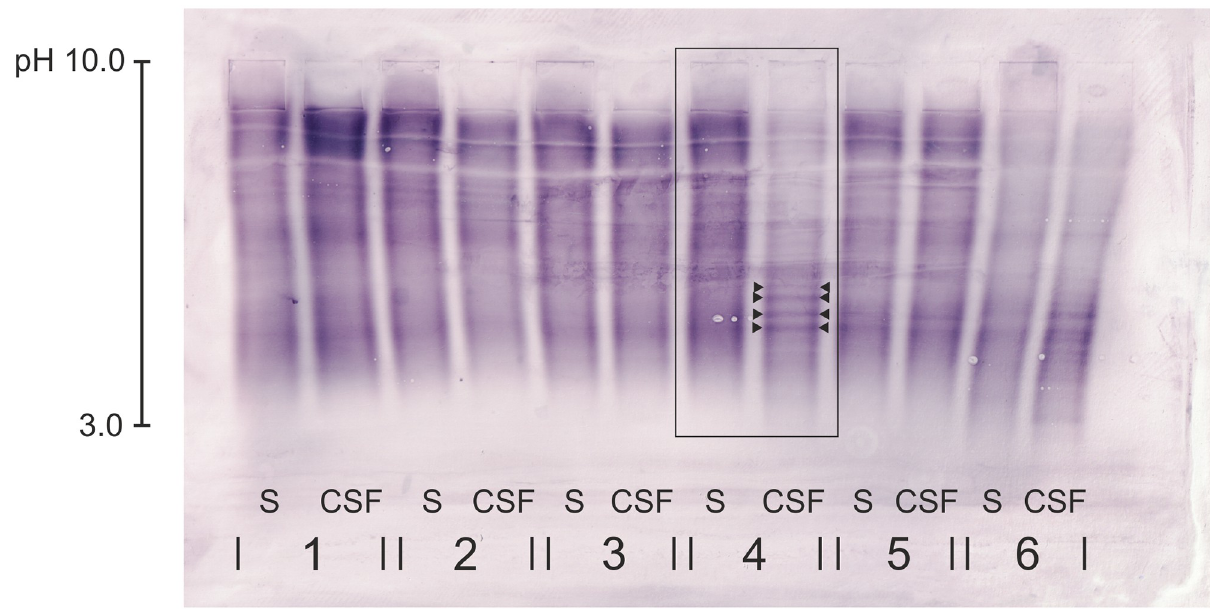
Fig 5. Immunoblot with serum and CSF samples from five canine patients (nos. 1–5) and one human MS patient (no. 6) after isoelectric focusing. Dog no. 1 was diagnosed with intracranial neoplasia, dog no. 2 and dog no. 3 with idiopathic epilepsy, dog no. 4 with MUO, and dog no. 5 with a disease outside the CNS. CSF-specific OCBs (equivalent to pattern 2 and 3 of the described patterns in human medicine; OCBs highlighted between arrowheads) were detected in dog no. 4. The samples from the human MS patient served as positive controls. CSF = cerebrospinal fluid, MS = multiple sclerosis, MUO = meningoencephalitis of unknown origin, CNS = central nervous system, OCBs = oligoclonal bands.